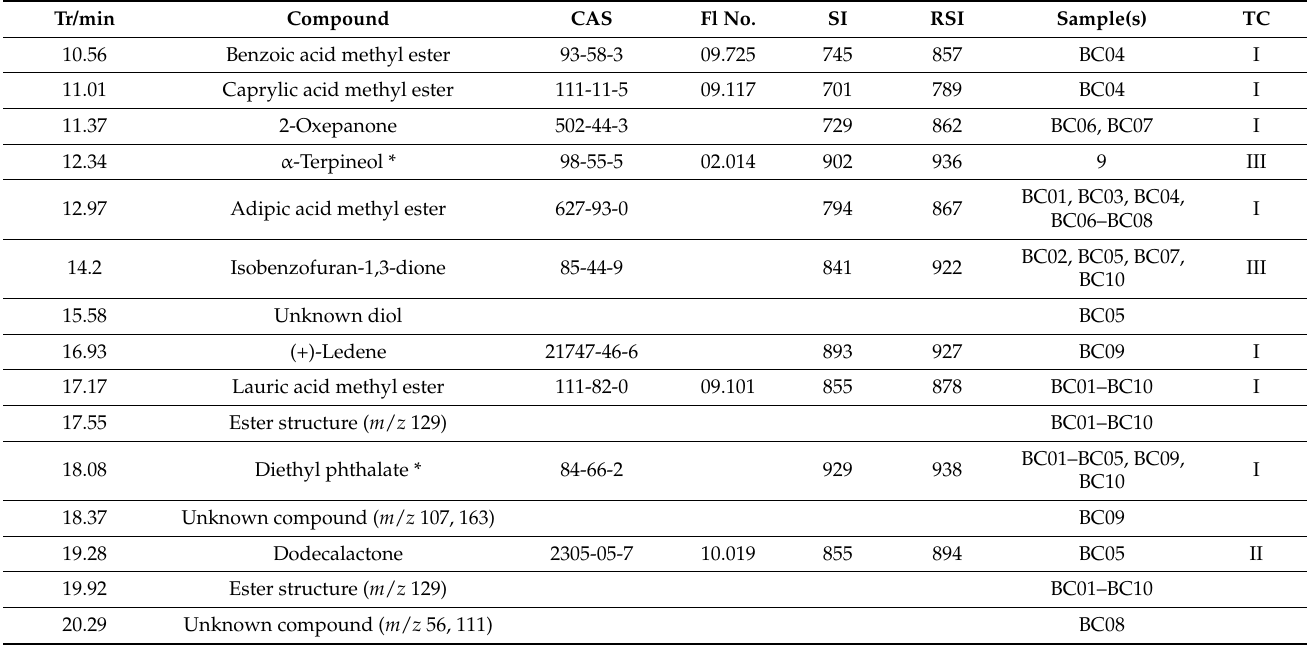
Table 3. Compounds identified via GC-MS analysis after extraction with MeOH as a